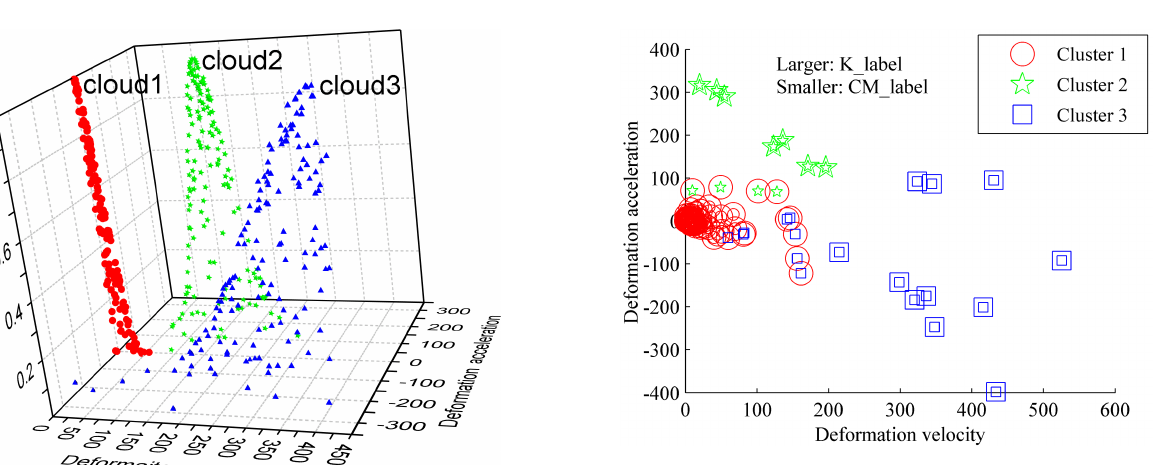
Figure 5. Comparison of K_label and